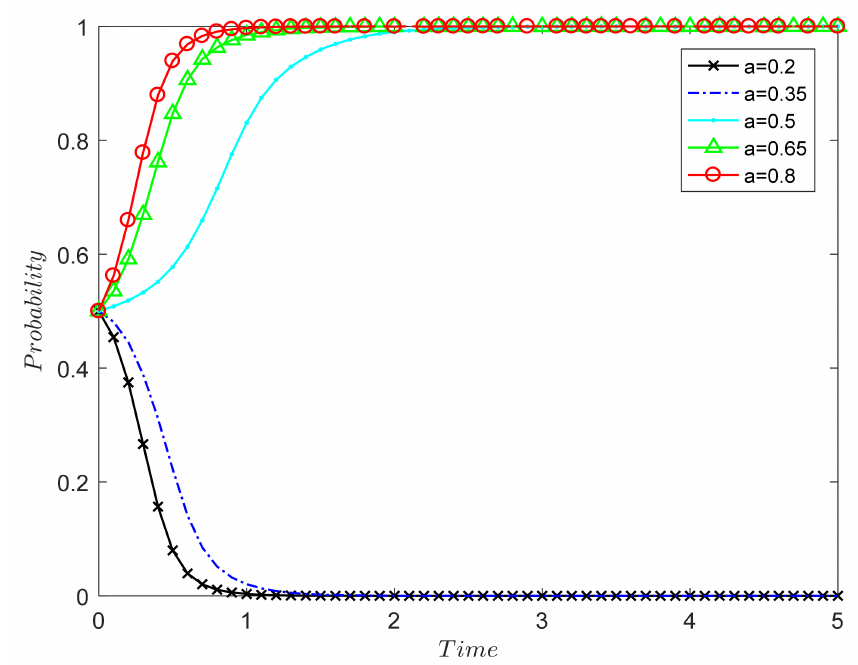
Figure 3. System evolution trajectory under different government supervision rates a